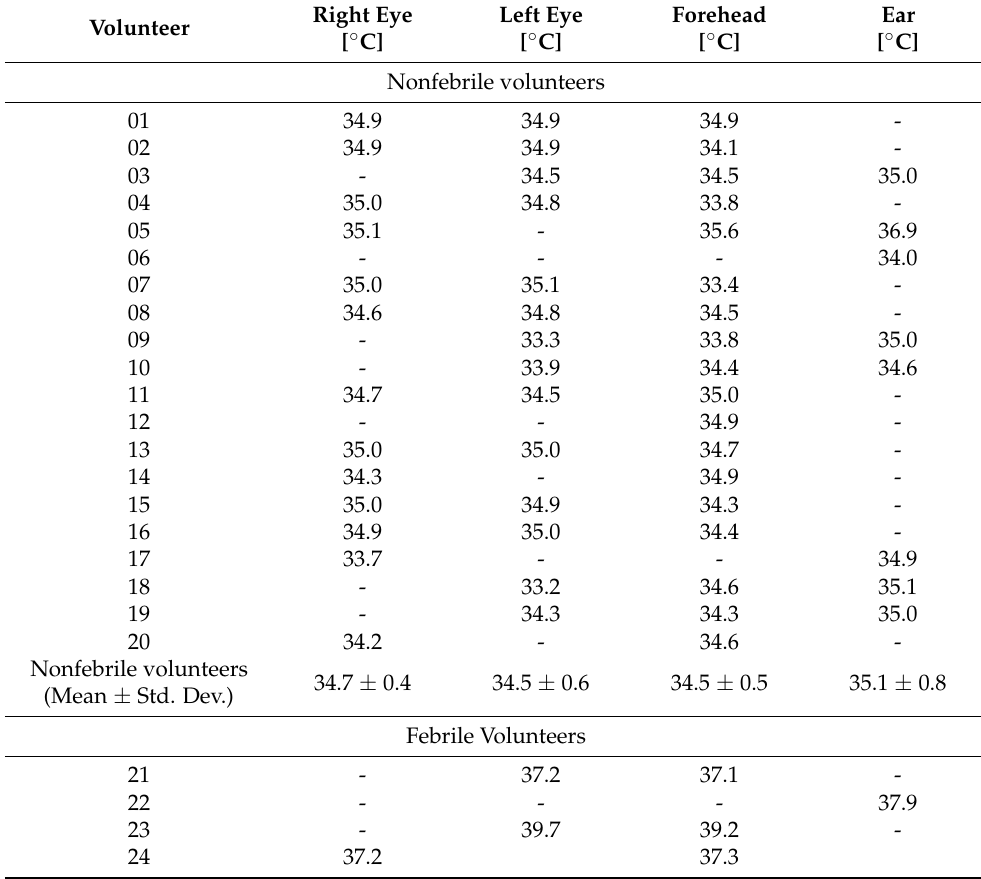
Table 2. Estimated Volunteer